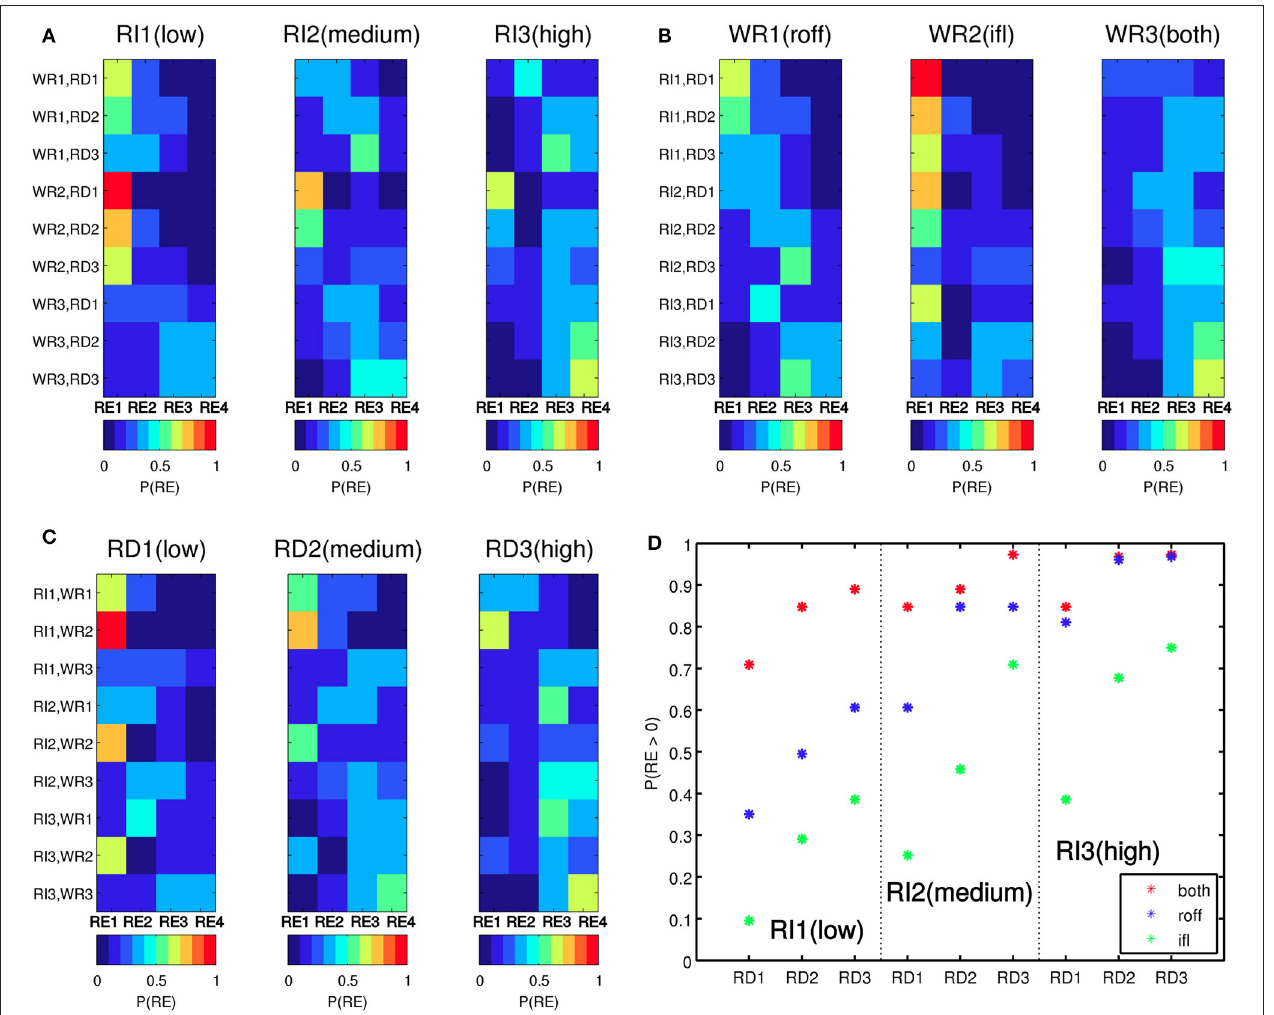
FIGURE 4 | Probabilistic patterns found within the Conditional Probability Table (CPT) of the Remobilization Efficiency (RE) node, arranged according to its parent nodes: rainfall intensity (RI, A ), water-routing mechanism (WR, B ) and rainfall duration (RD, C ). In (D) , we show the probability that deposited tephra is remobilized [i.e., P(RE > 0)] for each water-routing mechanism and as a function of the rainfall characteristics (RI and RD). The patterns displayed are in agreement with the scientific knowledge collected about the physical processes responsible for the rainfall triggering of lahars (see Table 2 and text for more details). roff, runoff dominant; ifl, infiltration dominant. RE1, RE2, RE3, RE4 denote the states zero, low, medium, and high,